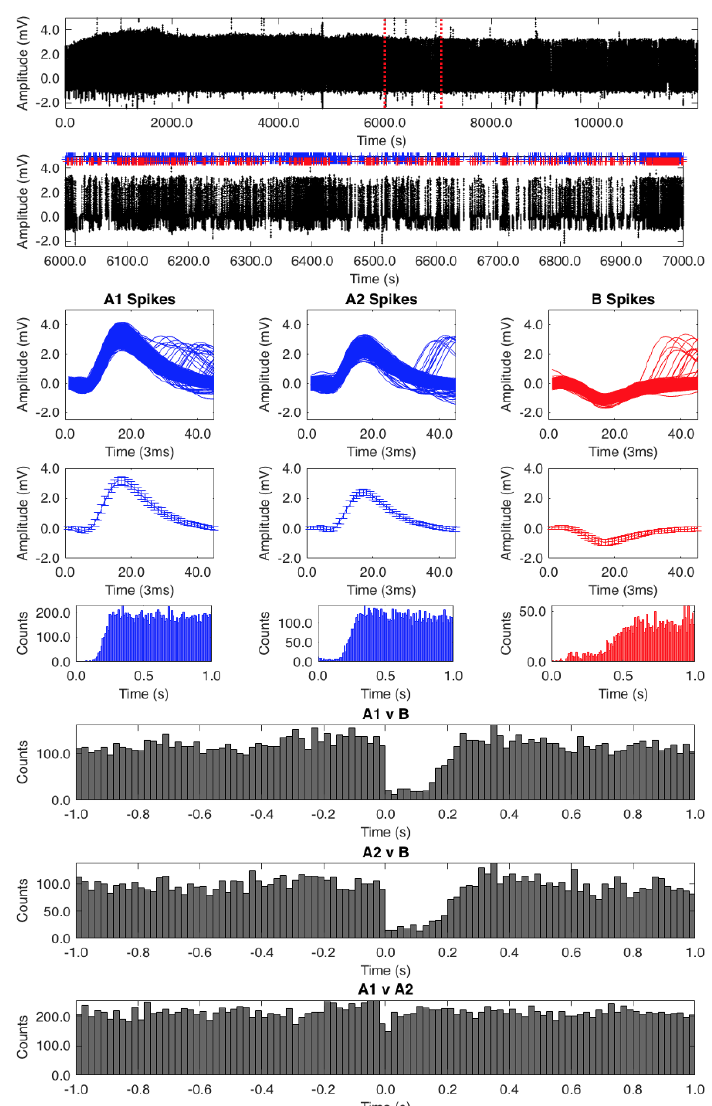
Figure 2. Auto- and cross-correlation analysis. The top trace shows the unaltered record containing all unmarked spikes. The second trace shows an expanded 1000 s segment between the red dotted lines in the top trace. The uppermost square windows show the superimposed A 1 , A 2 , and B spike waveforms, below which are the average spike waveforms (+/ − SD). Below these are the auto- correlograms for each spike classification. The bottom three histograms are cross-correlograms for the A 1 vs. B, A 2 vs. B, and A 1 vs. A 2